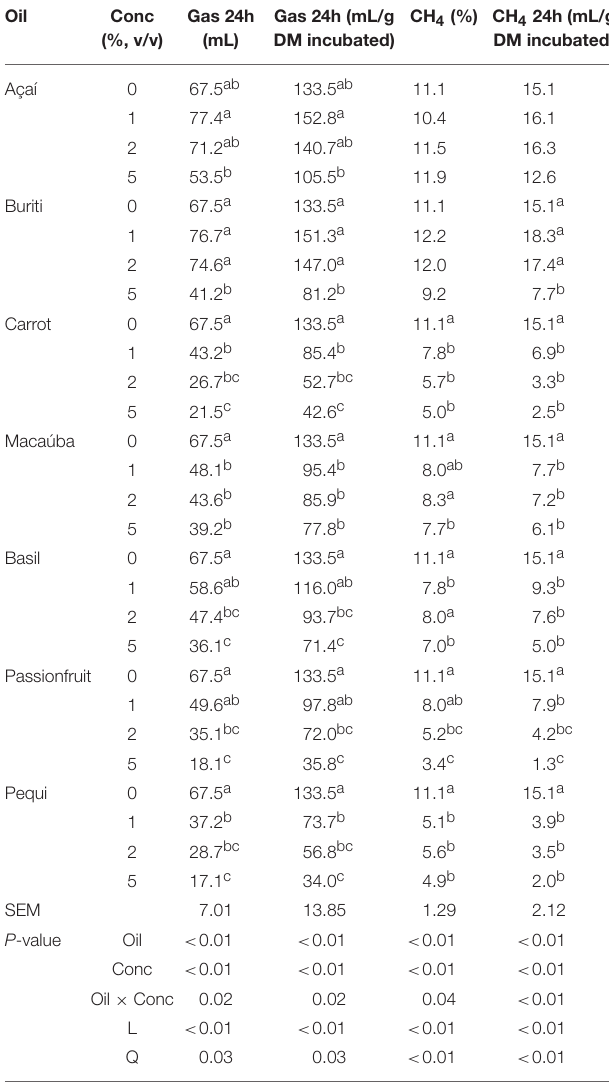
TABLE 4 | Effect of different oils on accumulative gas and methane production in an in vitro batch culture using a hay-based